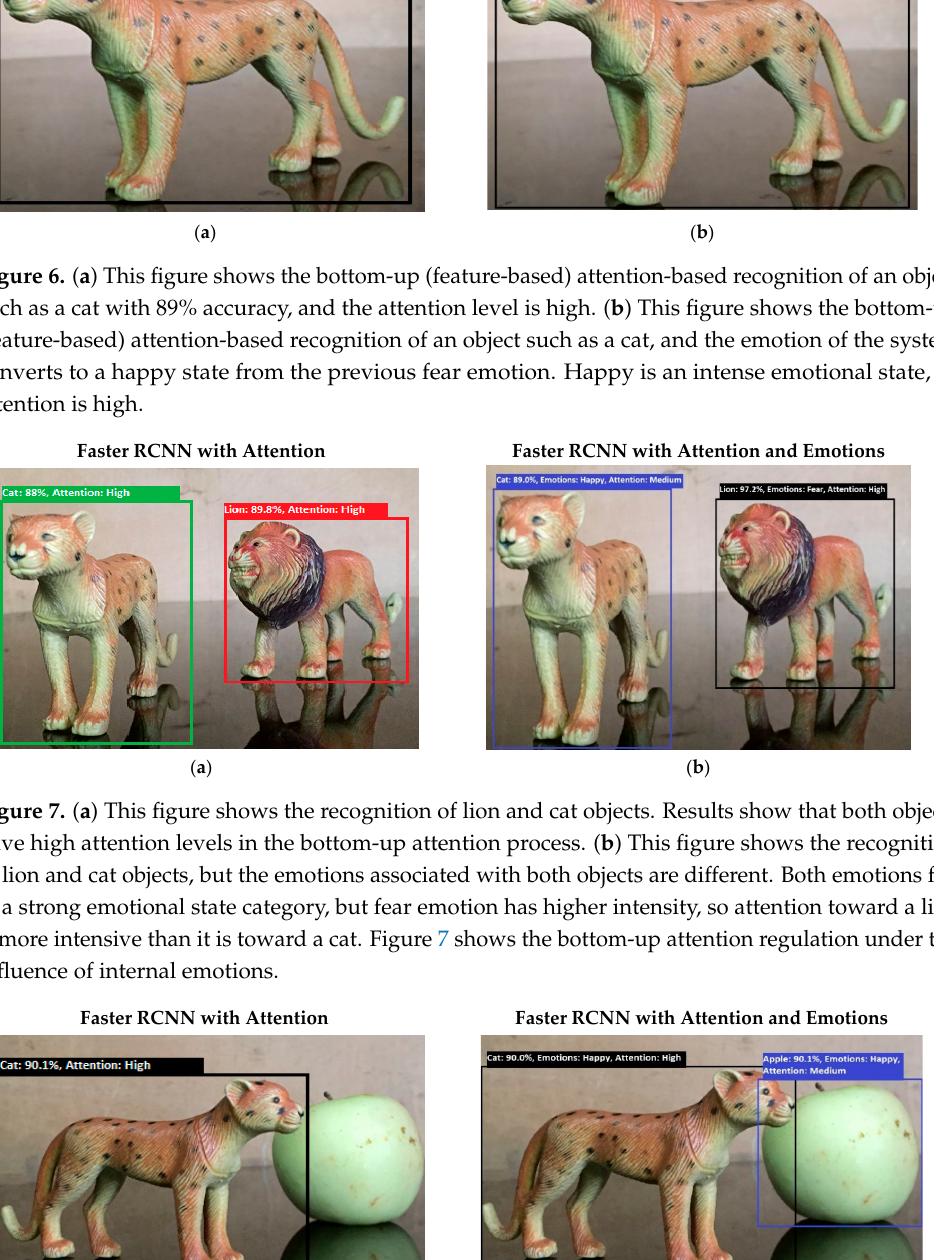
Figure 8. ( a ) The system’s performance in the top-down (goal-driven attention) attention process. The system generated a query to “find the cat” in the given picture. The intelligent system recognizes cat objects with a high attention level. ( b ) This figure shows the system’s performance in the top-down (goal-driven attention) attention process. The intelligent system recognizes both objects: apple and cat. Both objects have happy emotions, but the attention of the system diverts towards the target object. The system generated a query to “find the cat” in the given picture.